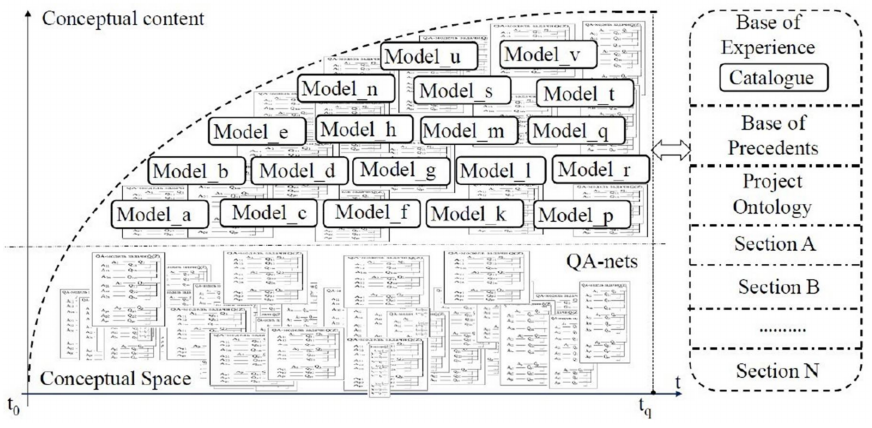
Figure 12. Beginning the results of conceptual solving the